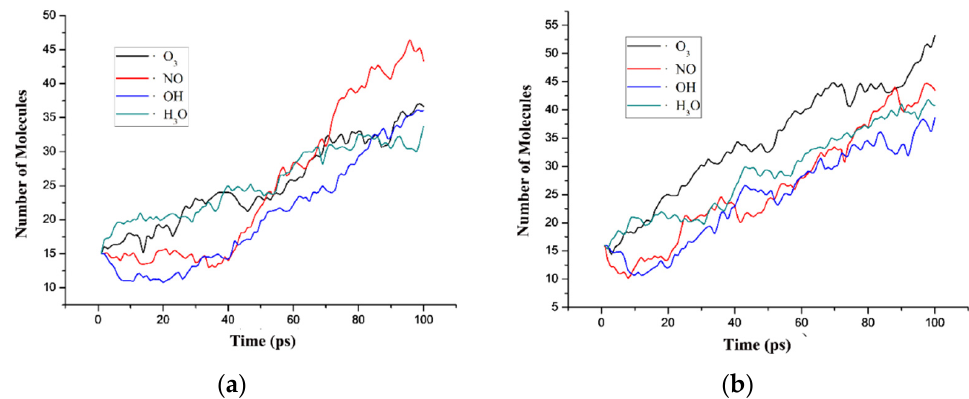
Figure 13. Number of molecules in different systems treated by reactive species. ( a ) PI neat; ( b ) PI/BNNS.